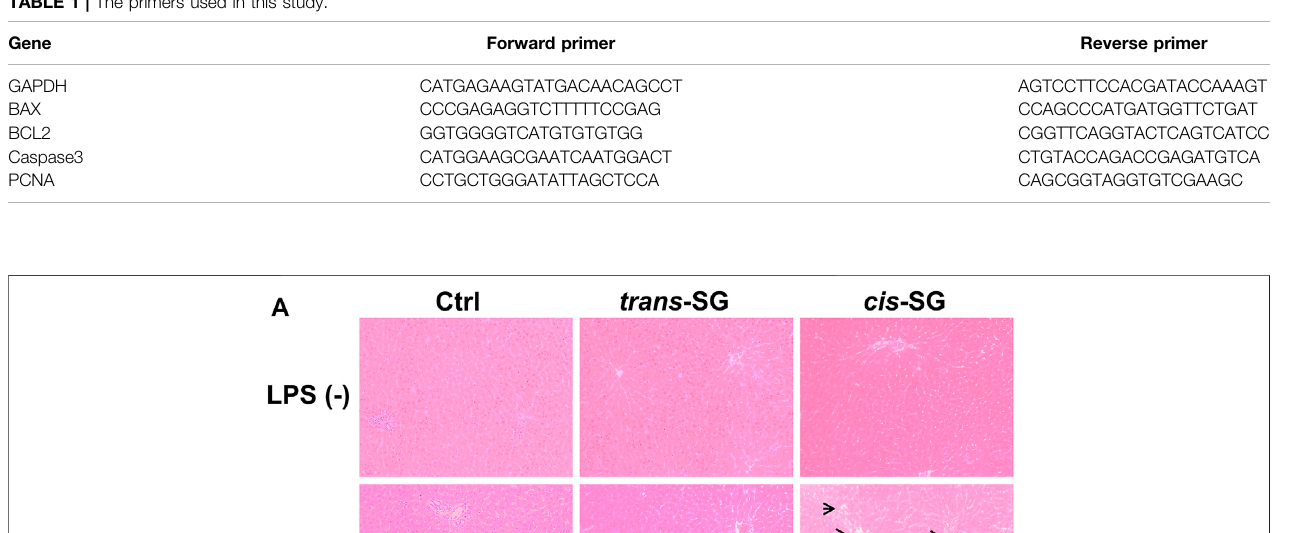
Frontiers in Pharmacology |